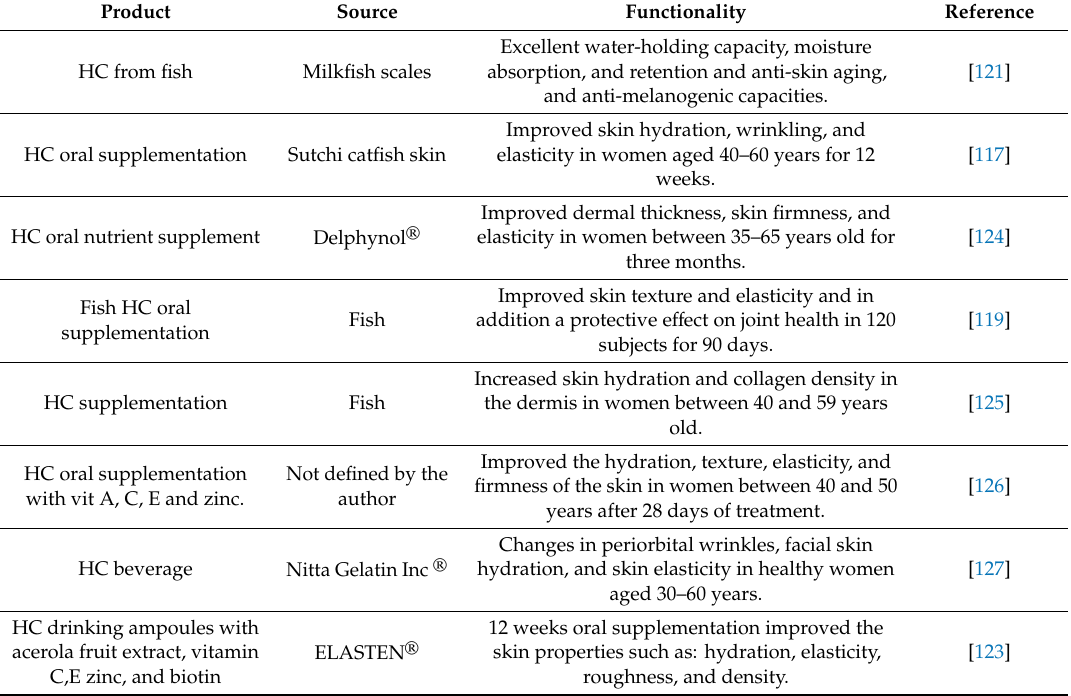
Table 2. Hydrolyzed collagen (HC) applications as functional supplementation food with positive e ff ect on the